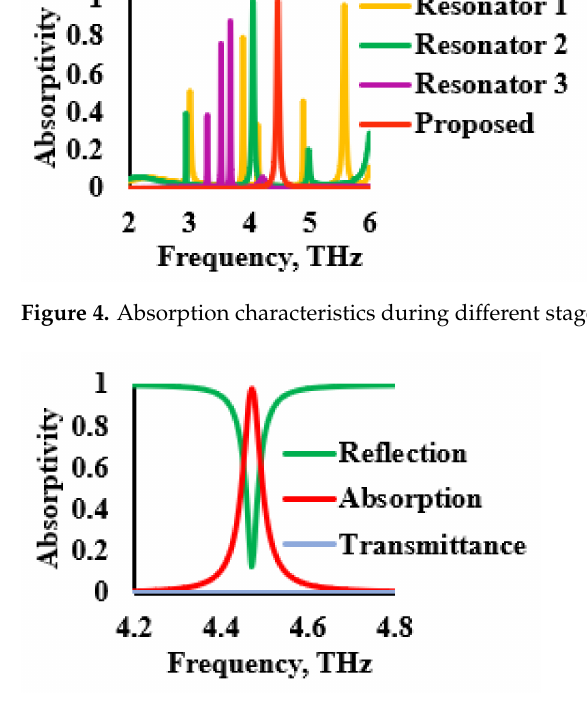
Figure 5. Reflection, transmittance, and absorption characteristics of the THz